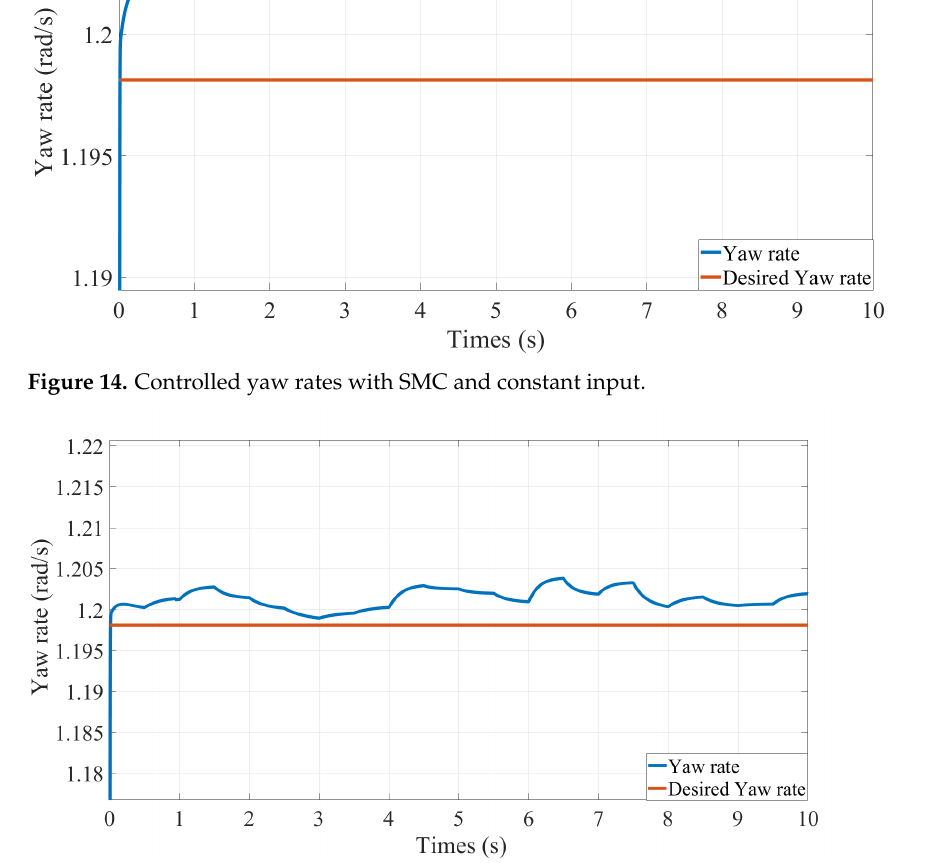
Figure 15. Controlled yaw rates with disturbance with constant